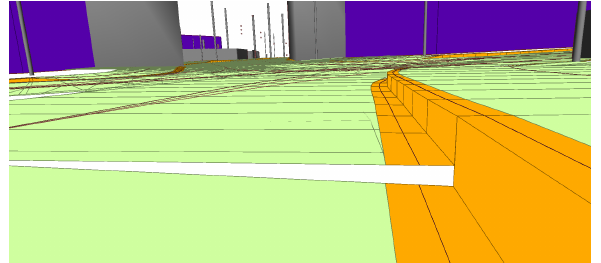
Figure 17. Dataset containing a driving lane gap of around 6cm at a road transition.